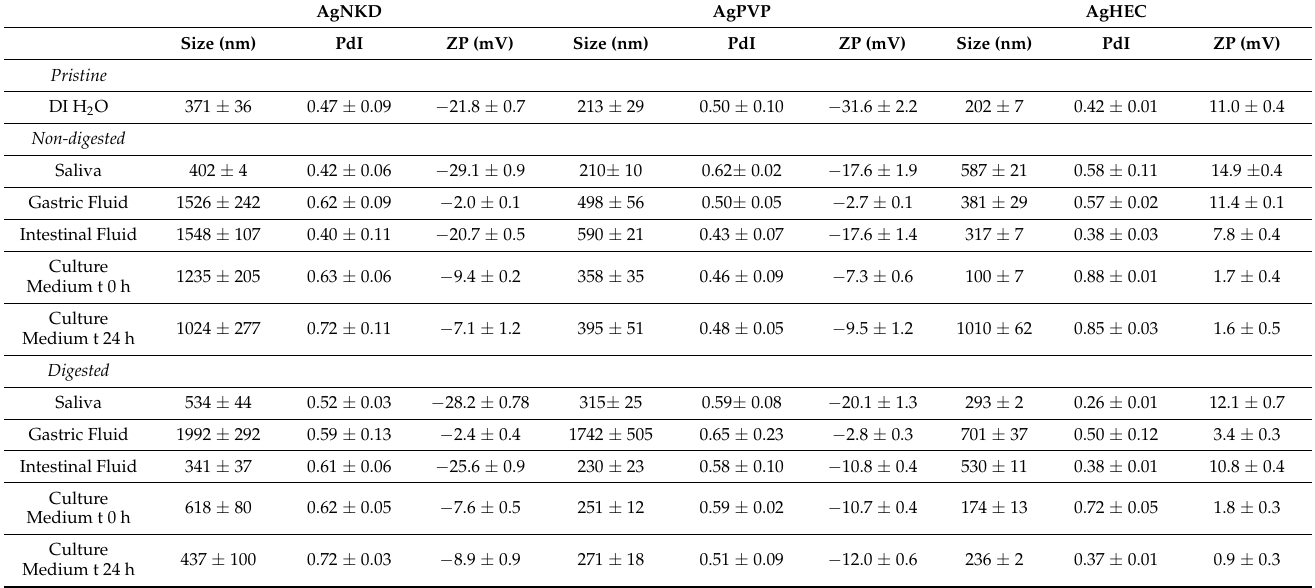
Table 1. Physicochemical characterization of Ag NPs 1